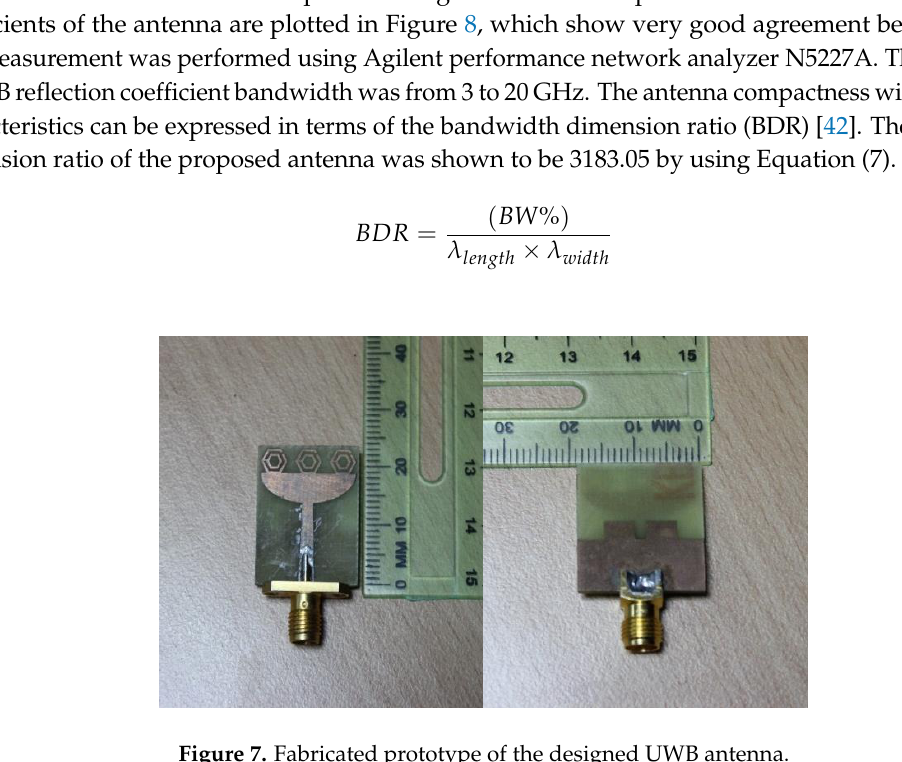
( b ) Figure 6. Proposed UWB metamaterial antenna. ( a ) Front view and ( b ) back view. Table 3. Design parameters of the proposed antenna. Parameters